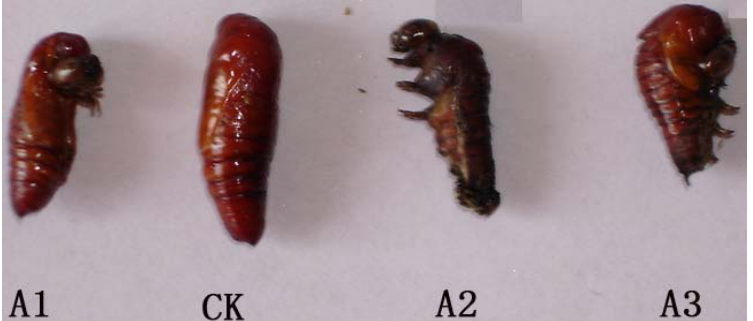
Figure 3. Effect of fraxinellone on M. separata pupation ( A1 , A2 and A3 were abnormal pupae after treated by fraxinellone; CK : blank control